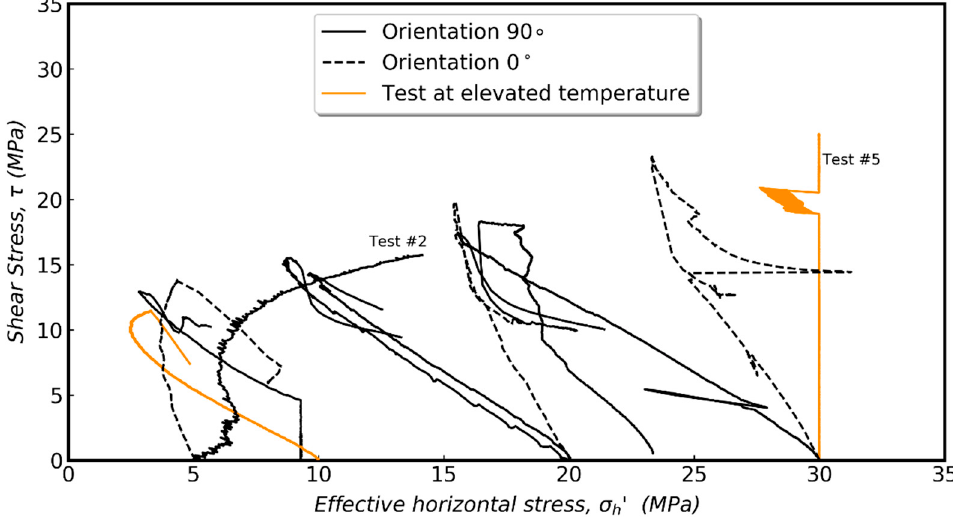
Figure 9. Shear stress versus effective horizontal stress during undrained shearing of vertical (solid line) and horizontal (dashed line) samples.